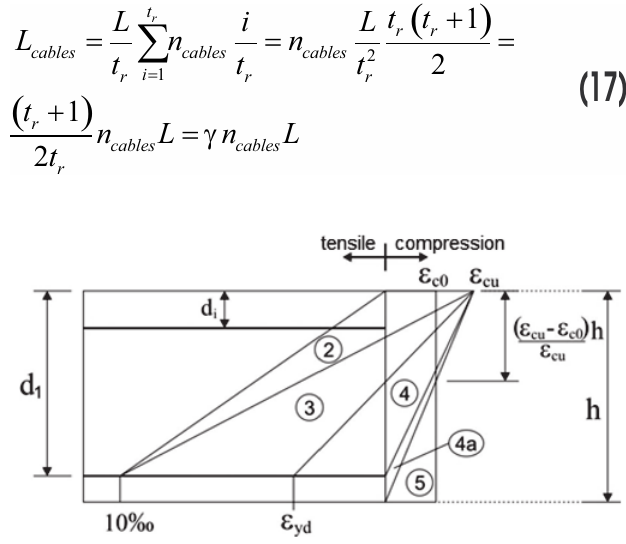
Design domains (or Ultimate Limit Strain Distribution) for a cross section (adapted from NBR 6118